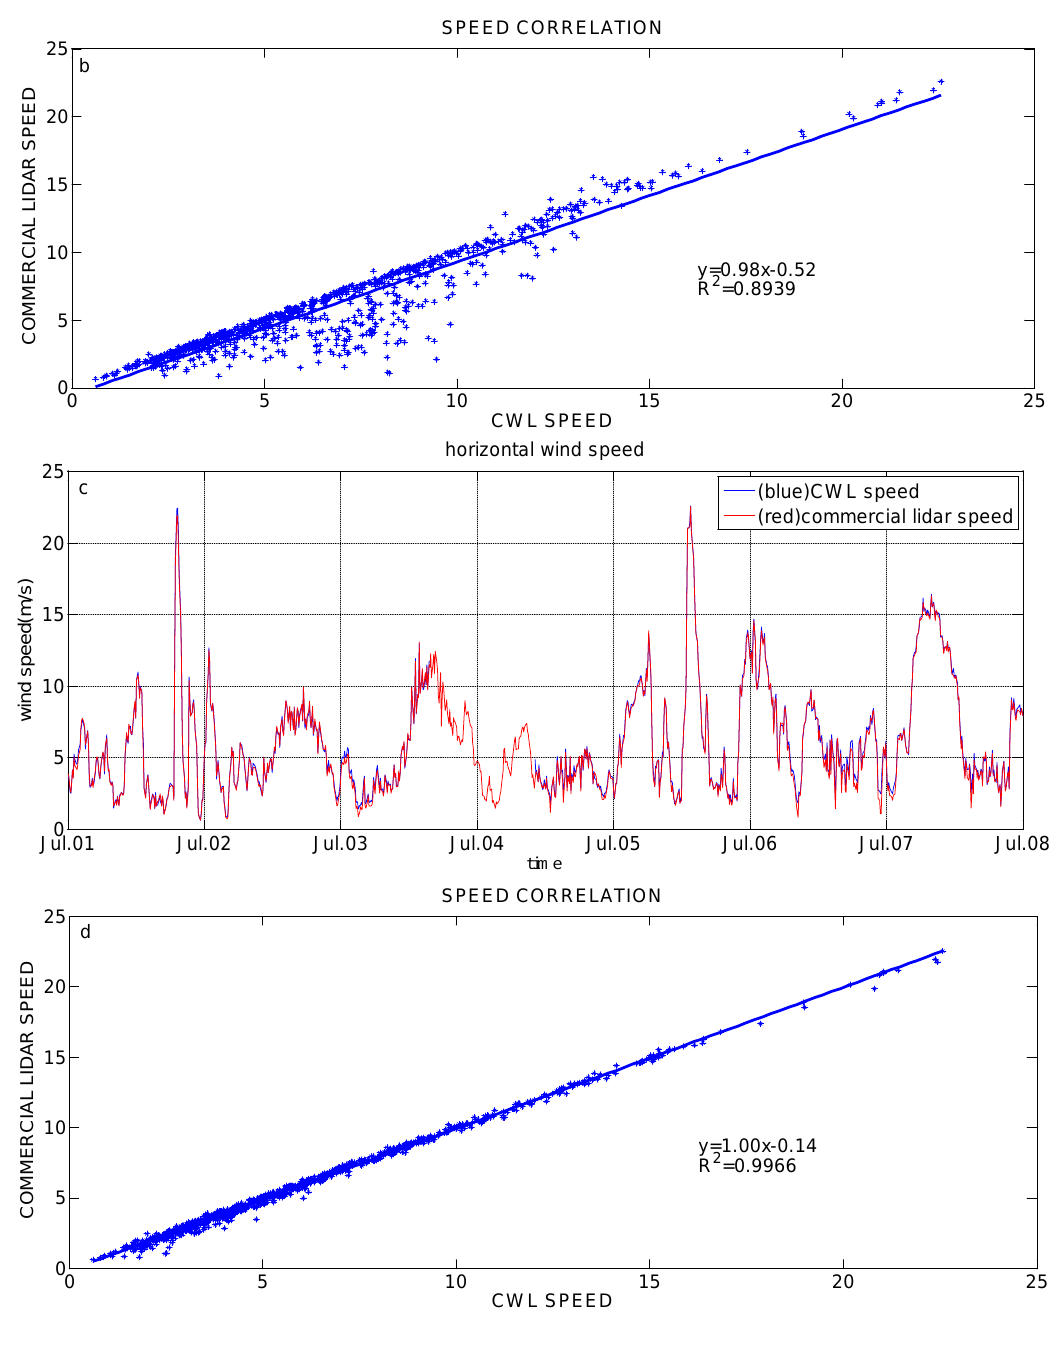
Figure 10. Horizontal wind speed at 120 m: ( a ) horizontal wind speed after COG; ( b ) correlation between the horizontal wind speed after COG and that of the commercial lidar; ( c ) horizontal wind speed after CR-CFAR; and ( d ) correlation between the horizontal wind speed after CR-CFAR and that of the commercial lidar.